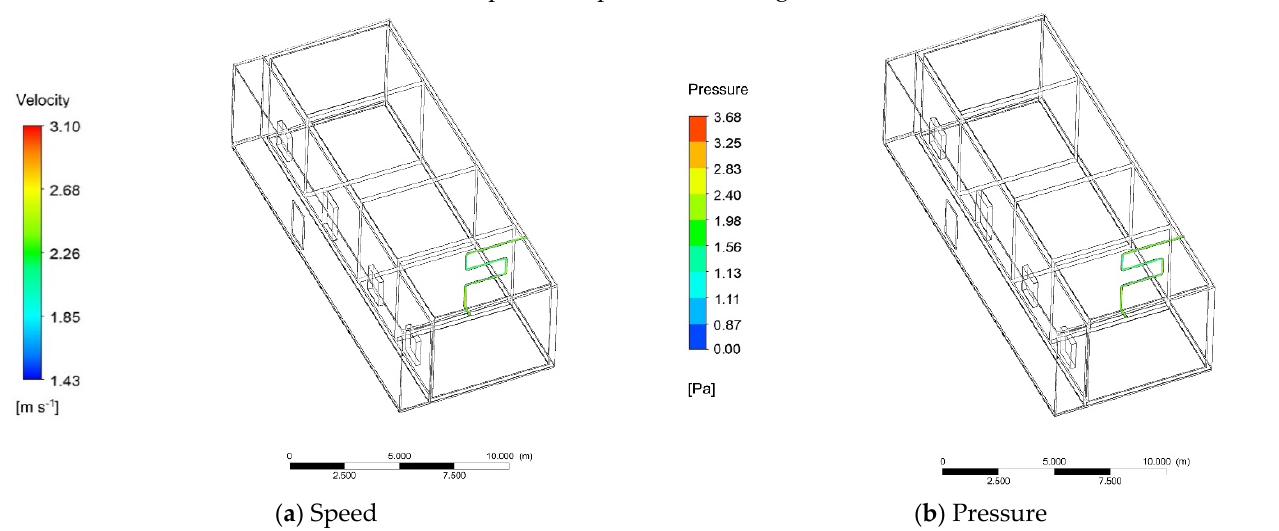
Figure 9. ( a ) Speed of the flue gas. ( b ) Pressure of the flue gas. Temperature of the pipe